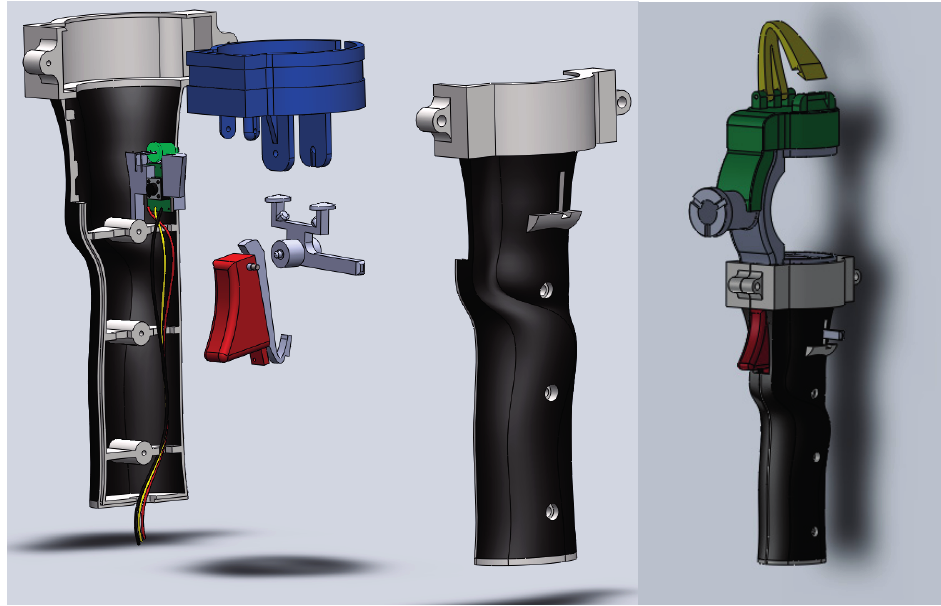
Figure 3. Final design of the handle with the synchronization